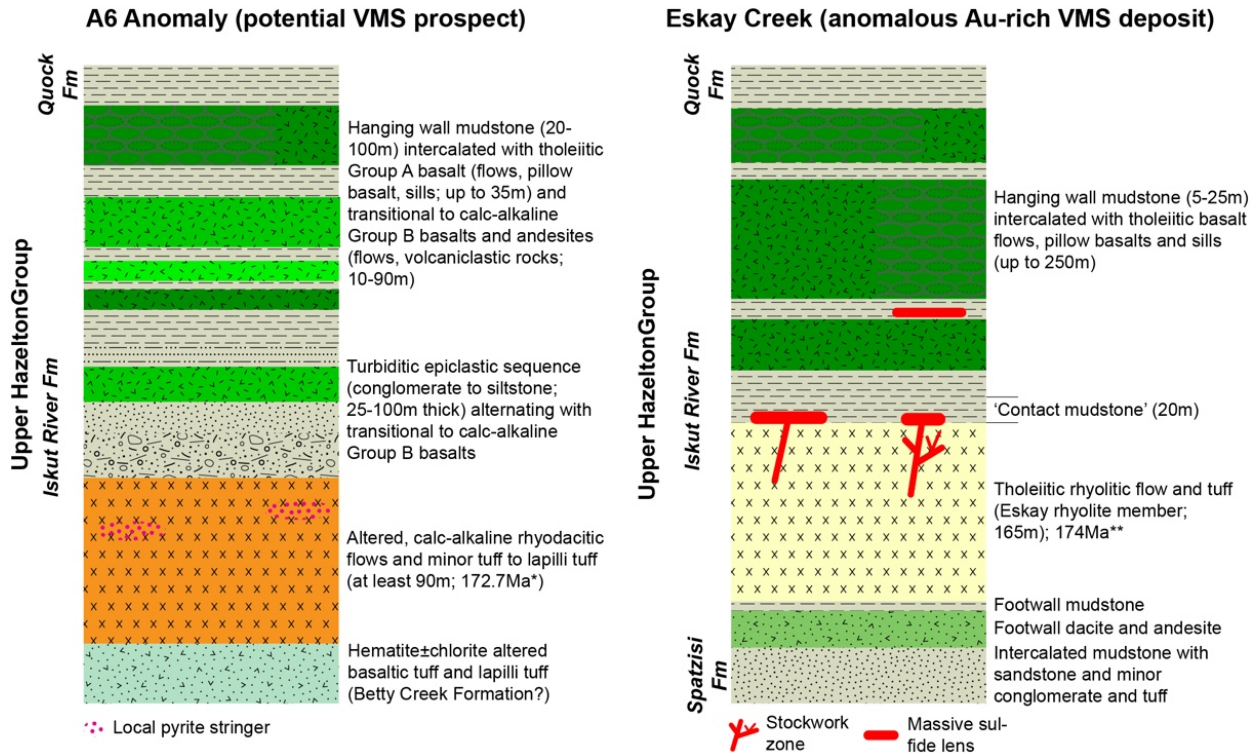
Figure 22. Comparison of Upper Hazelton Group stratigraphy at A6 Anomaly (left) and Eskay Creek deposit (right; modified after [41]; * [45], ** [2], sections not to scale.